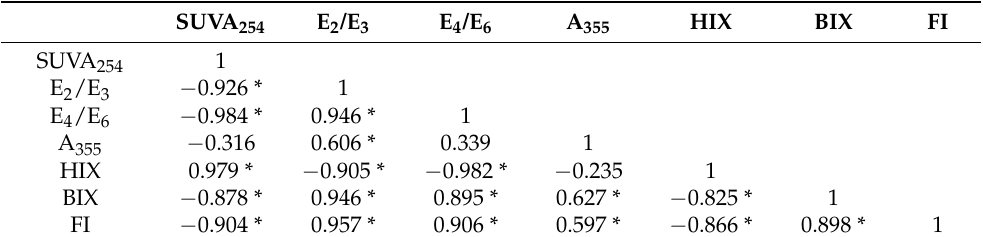
Table 5. Correlation among spectroscopy